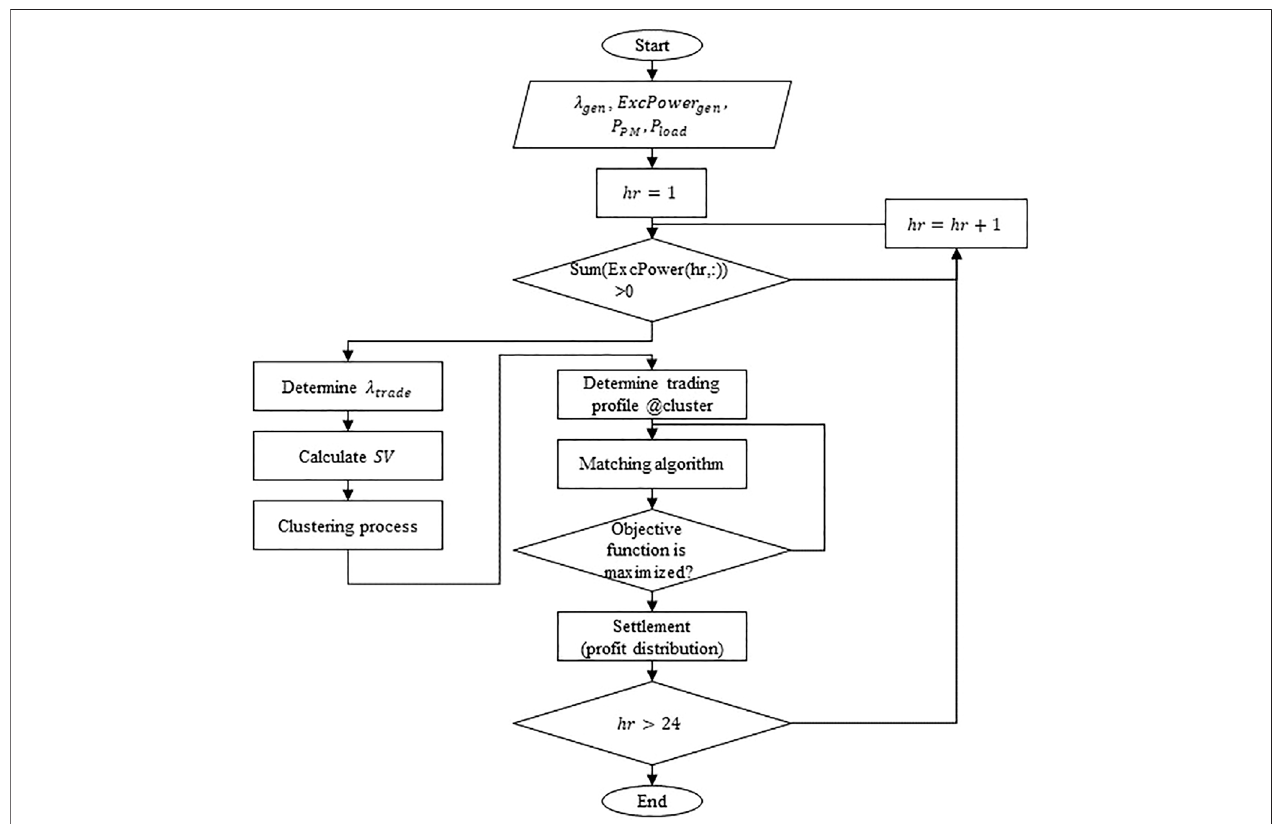
FIGURE 2 | Flowchart of modi fi ed operator-oriented P2P